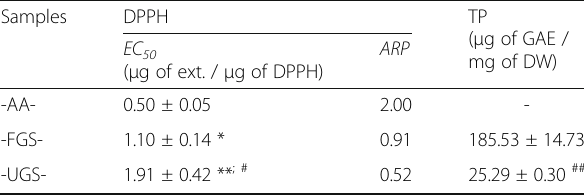
Table 1 Antioxidant reducing power and EC 50 values obtained in DPPH assay, and total phenolic compounds Samples